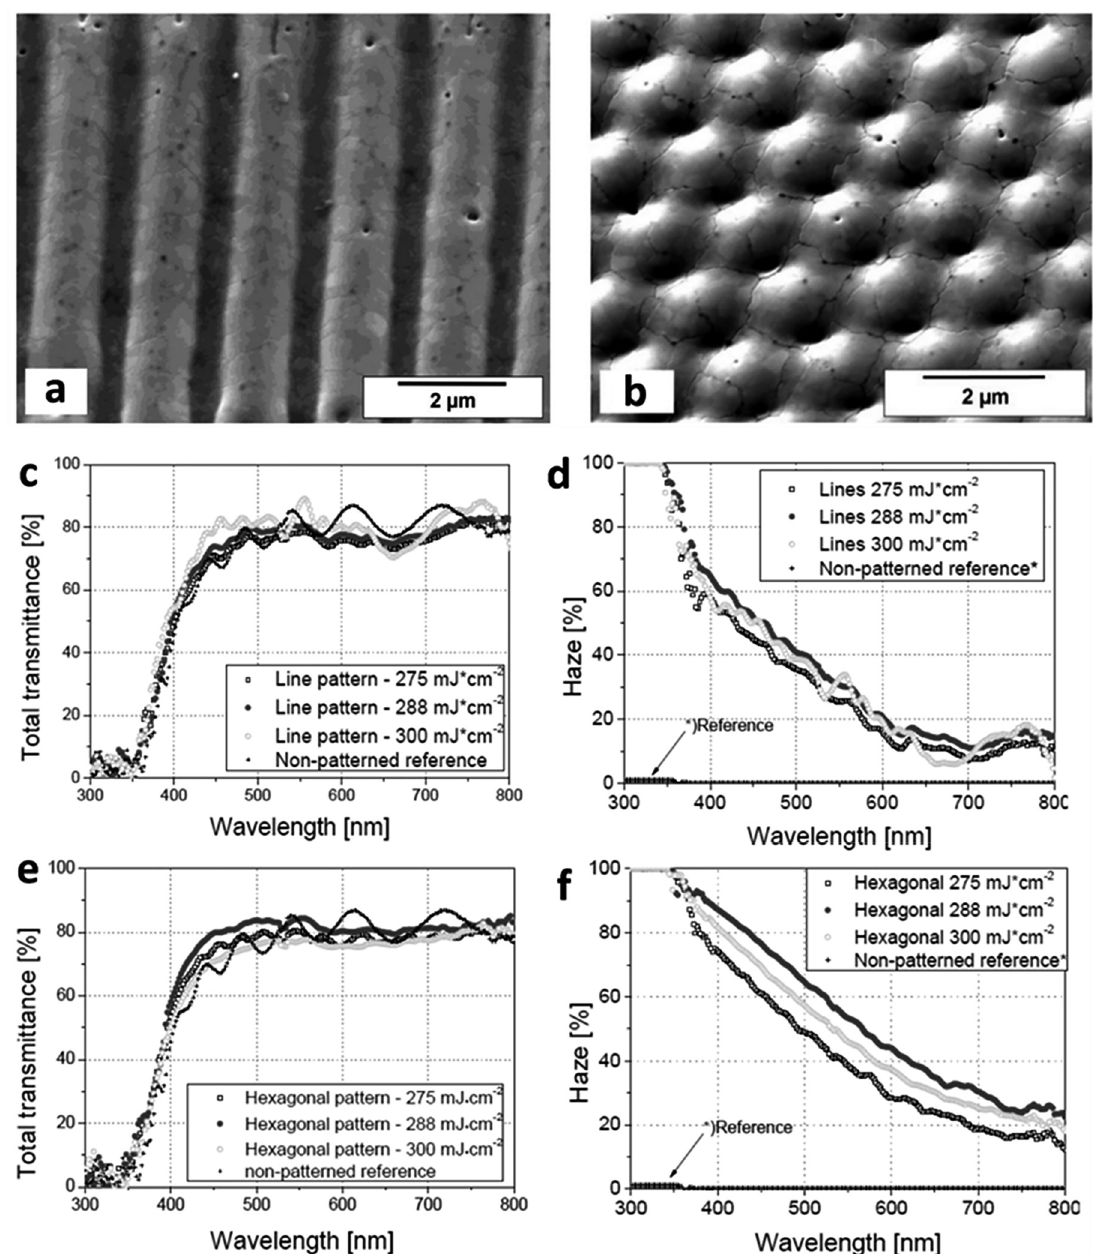
Figure 15: SEM micrographs of AZO films structured by DLIP with a (a) line-like pattern and (b) hexagonal pillar-like array. Total transmittance and haze factor of the hexagonal ((c) and (d), respectively) and line patterns ((e) and (f), respectively). Figures adapted from ref. [143] (© 2013 Elsevier